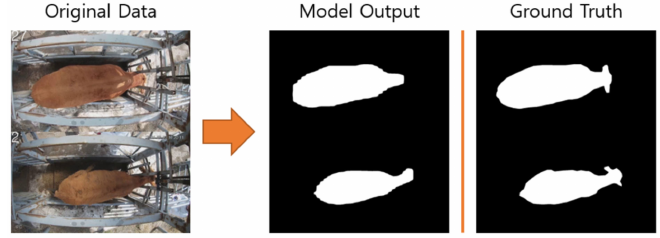
Figure 7. Image segmentation result of the FSS method.